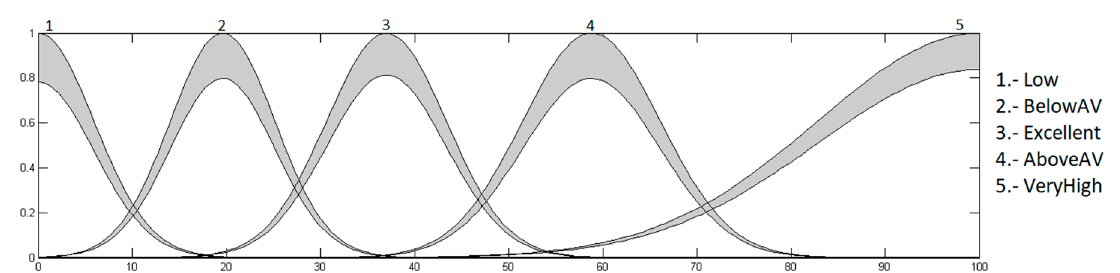
Figure 15. Age input with Gaussian MFs.